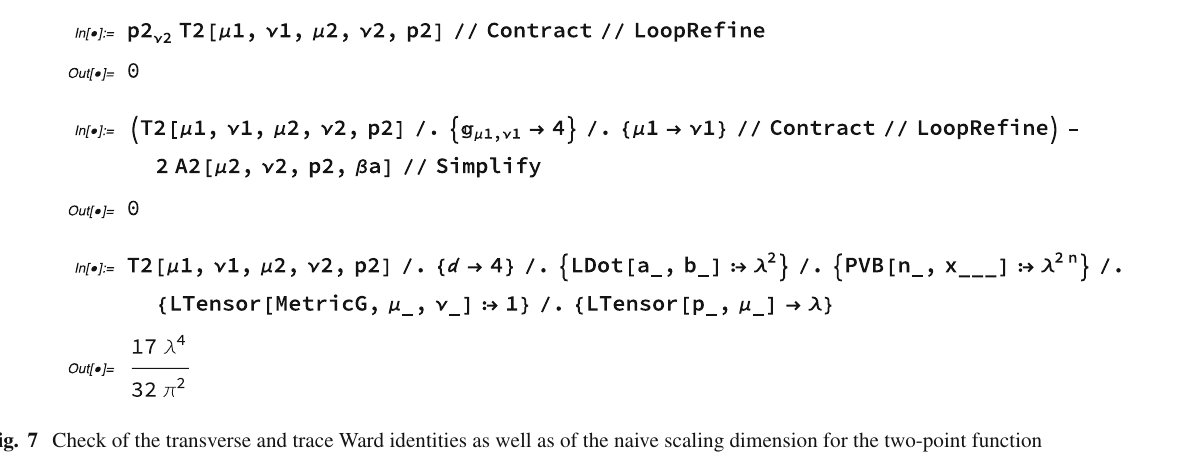
Fig. 7 Check of the transverse and trace Ward identities as well as of the naive scaling dimension for the two-point